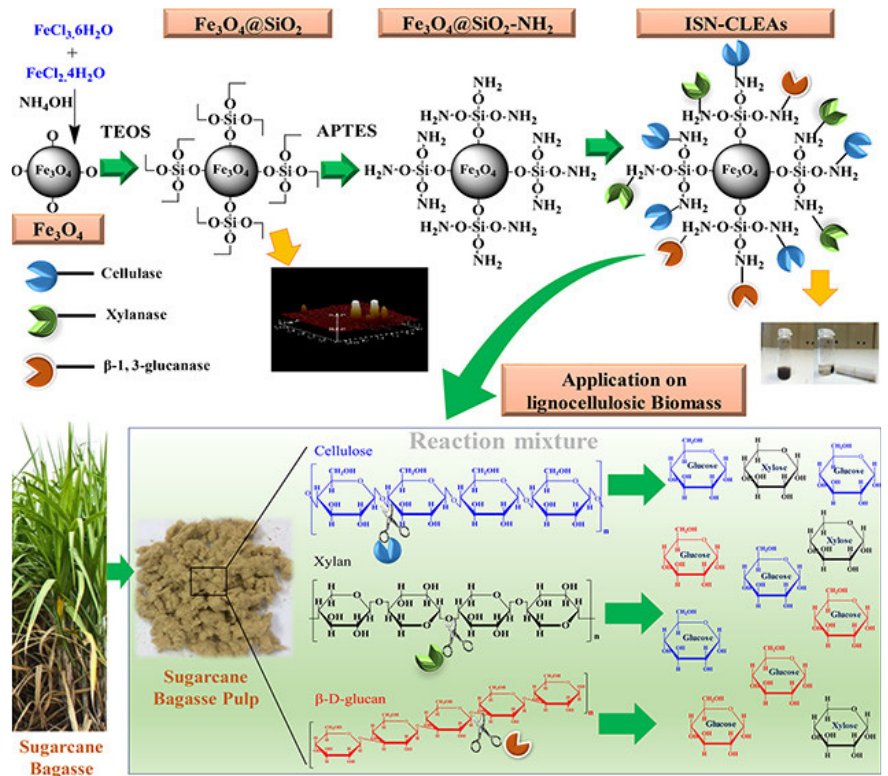
Figure 9. Schematic representation of the immobilization of three enzymes on amino-functionalized magnetite NPs and hydrolysis of sugarcane bagasse pulp. TEOS and APTES stand for tetraethoxysilane and (3-aminopropyl) triethoxysilane, respectively. Reproduced with permission from [138], American Chemical Society, 2018.